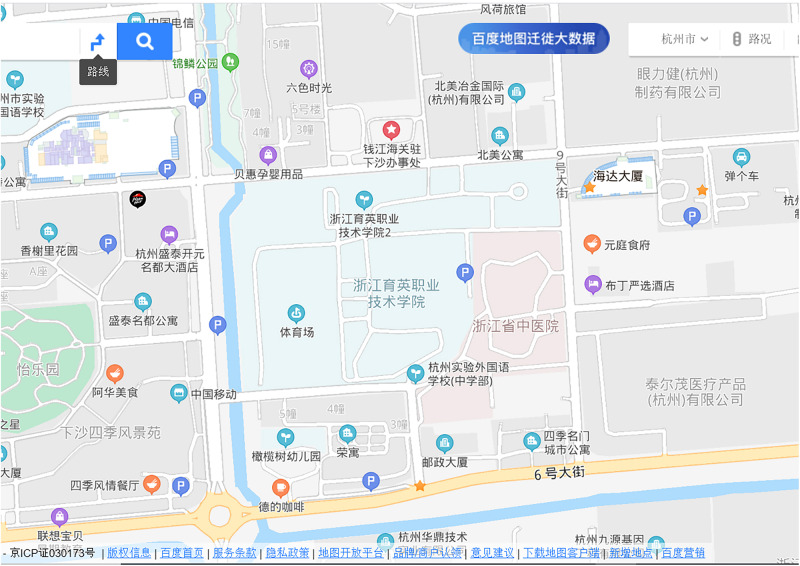
The assisted 2D map.